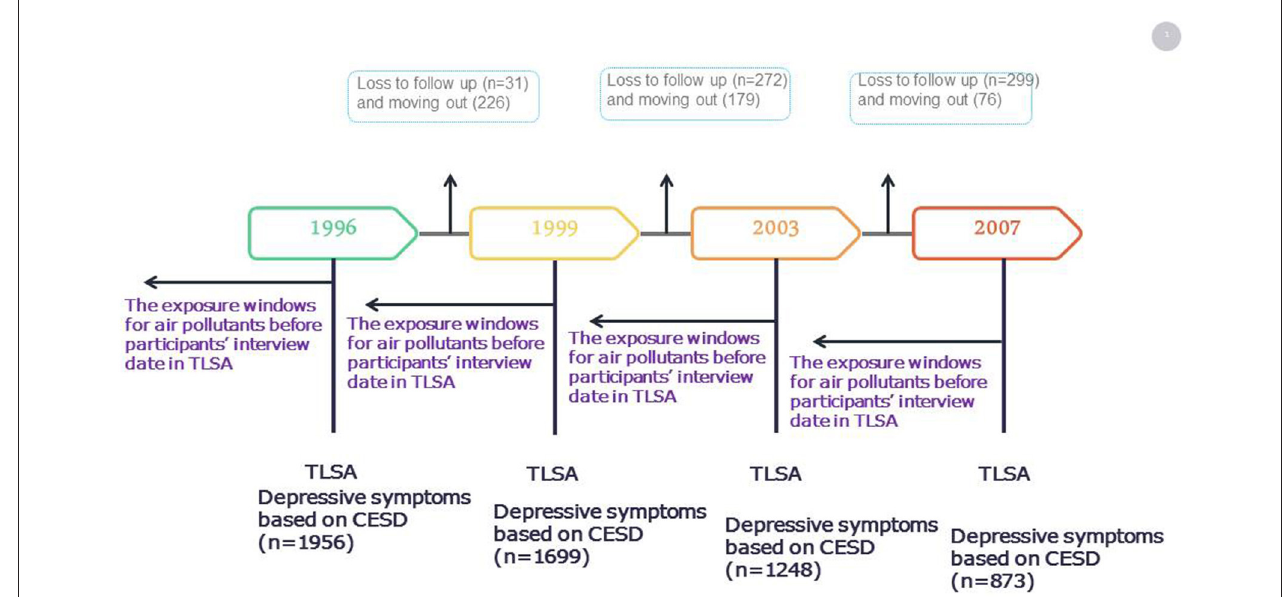
FIGURE 1 | Sample selection